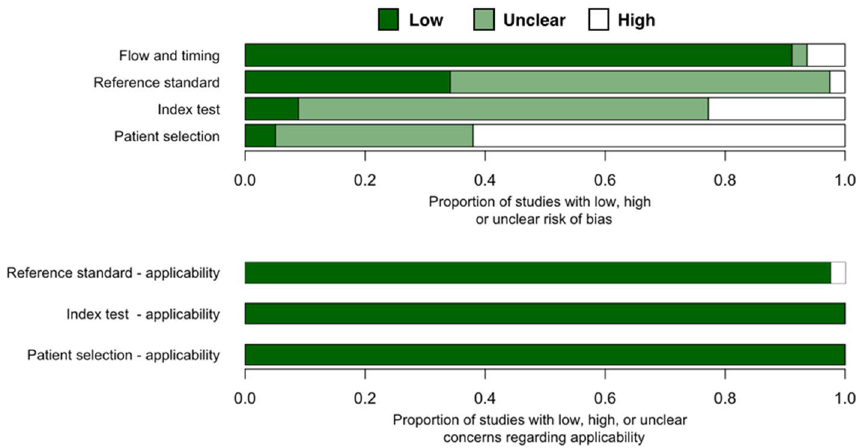
Figure 2. Quality assessment of diagnostic accuracy studies 2 (QUADAS-2) finding per domain for 81 studies included in this systematic